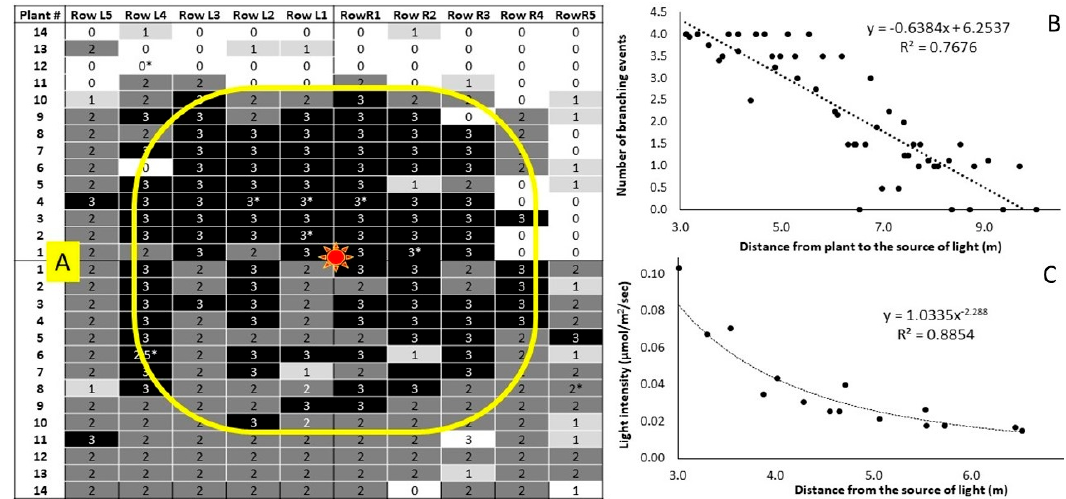
Figure 5. Results from the evaluation of the 50 W LED lamp treatment in Experiment 2 ( A ). The experimental area was planted in a 1.5 × 0.5 m grid with ten rows and 14 plants of CM 4919-1 (top) and GM971-2 (bottom). The graphic indicates the number of branching events observed at 148 days after planting (DAP) for each plant. There were eight missing plants identified with an asterisk; the missing information for these plants was replaced by the average of the surrounding plants. Plants inside the yellow ring received enough stimulus to flower earlier. The red star marker indicates the position of the source of light. ( B ) relationship between average number of branching events 206 DAP and average distance to the source of light (both genotypes shown; data from plants at the same distance from the reflector were averaged). ( C ) Average intensity of illumination in relation to the distance from the lamp based on 53 measurements. The yellow ring in ( A ) indicates plants that had received > 0.02 µ mol m − 2 s − 1 , the proposed threshold to induce earlier flowering (about 5–6 m from ground level to the center of the plot immediately below the